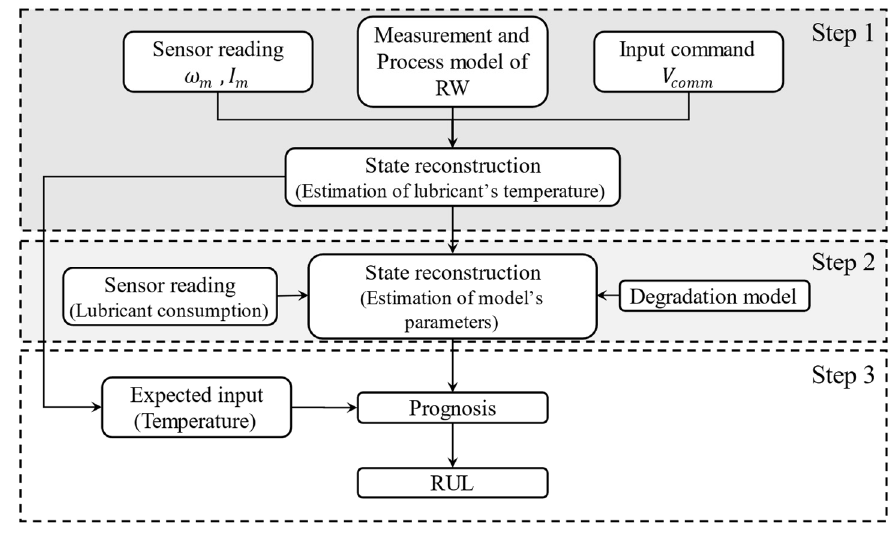
Figure 2. The steps to forecast the RUL of an RW.